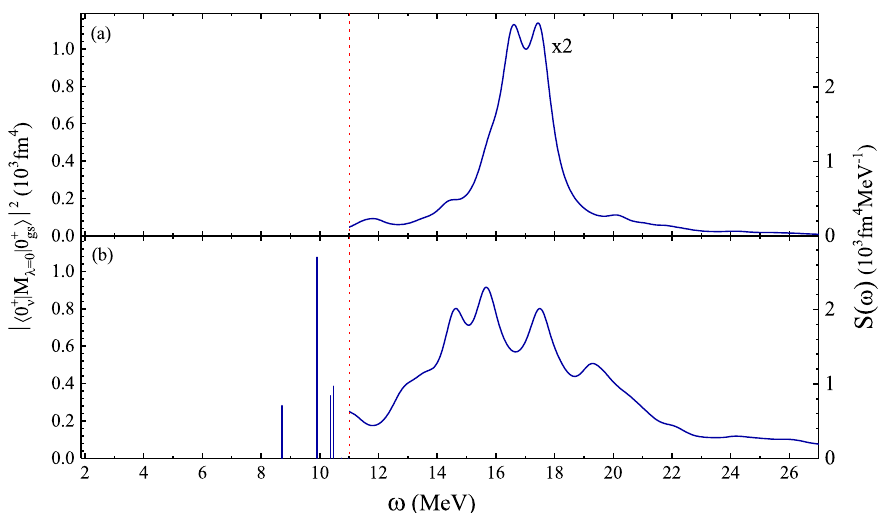
Figure 4. The phonon–phonon coupling effect on the ISGMR of 132 Sn. The RPA results (top panel ( a )) are scaled down by a factor of 2 for a better display. The results obtained with inclusion of the PPC effects are given in the bottom panel ( b ). The distributions were calculated with the Skyrme force SLy4. The unit of transition probabilities (the strength function) refers to the vertical axis on the left-hand (right-hand) side. The smoothing parameter 1 MeV was used for the strength distribution described by the Lorentzian function.